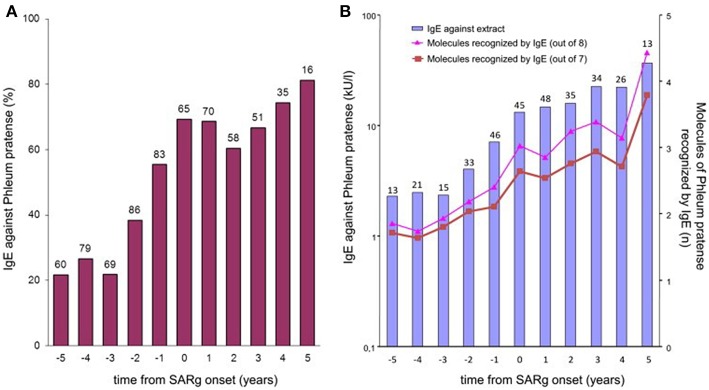
IgE to P pratense by time from onset of grass-related seasonal allergic rhinitis. (A) Bars show the prevalence of IgE sensitization (≥0.35 kUA/L) to P pratense (extract) in children whose sera were available at each point in time. The number of tested children is indicated over each bar. (B) Bars show the geometric mean levels of IgE antibodies to P pratense (extract) at each point in time in IgE antibody–positive sera. The numbers of tested children is indicated over each bar. Lines show the average number of all 8 (triangles) or only 7 (squares; Phl p 6 excluded) allergenic molecules of P pratense recognized by IgE antibodies at each point in time in IgE antibody–positive sera [reprinted from (11), Copyright 2012, with permission from Elsevier].